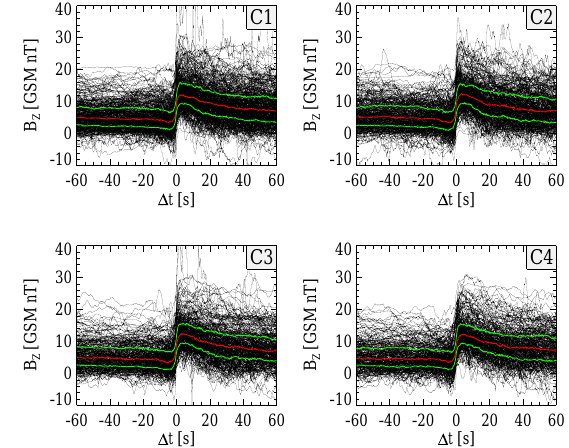
Superposed epoch analysis of 318, 282, 254, and 236 DFs that are selected by C1, C2, C3, and C4, respectively. The profiles of each DF event are centered at t DF . The red and upper and lower green lines indicate the medians, upper quartiles, and lower quar- tiles of the data,